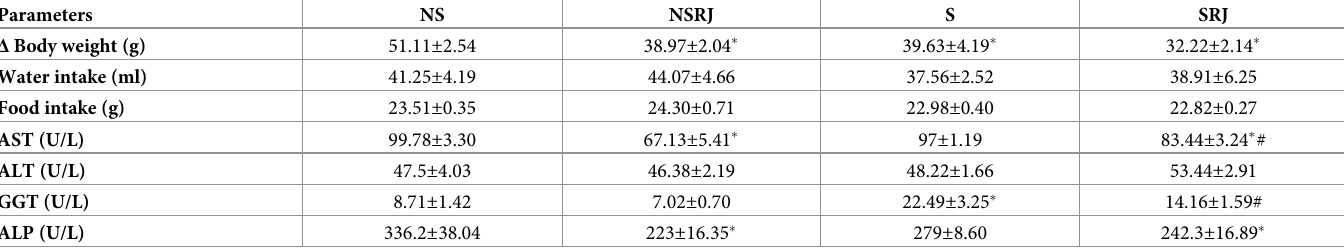
Table 1. The effect of the stress-induction by restraint and cold and supplementation of royal jelly on body weight, water intake, food intake and hepatic enzymes activities in plasma. Parameters